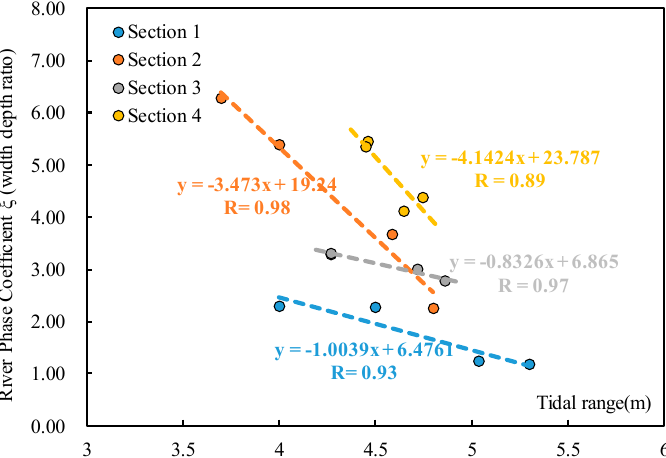
Figure 16. Average Annual Tidal Range and River Phase Coefficient ξ (width–depth ratio).